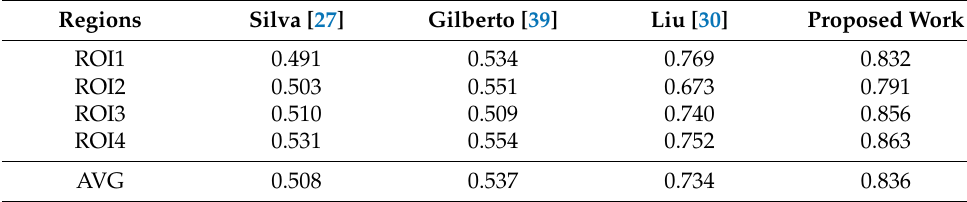
Table 4. Quantitative evaluation results of gradient similarity (GS).